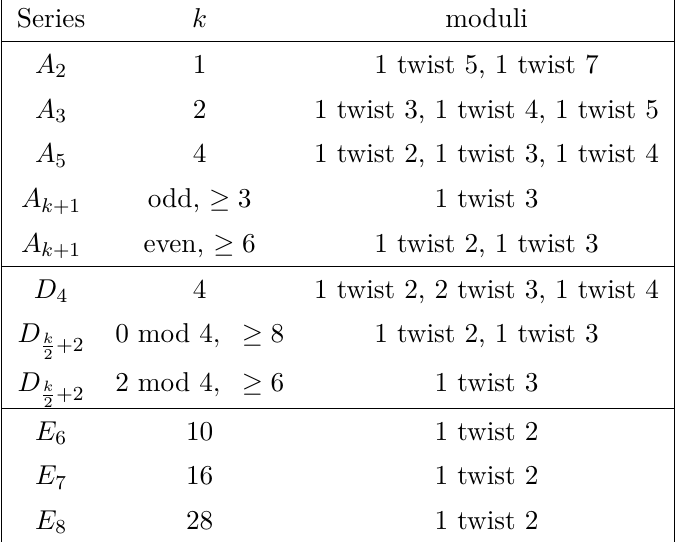
. k +2 identified on the cover ( r,s )